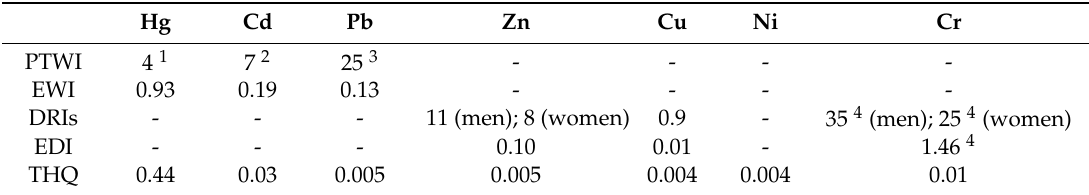
Table 2. Estimation of the dietary intake for Hg, Cd, Pb, Zn, Cu, Ni, and Cr through swordfish consumption based on average concentrations.